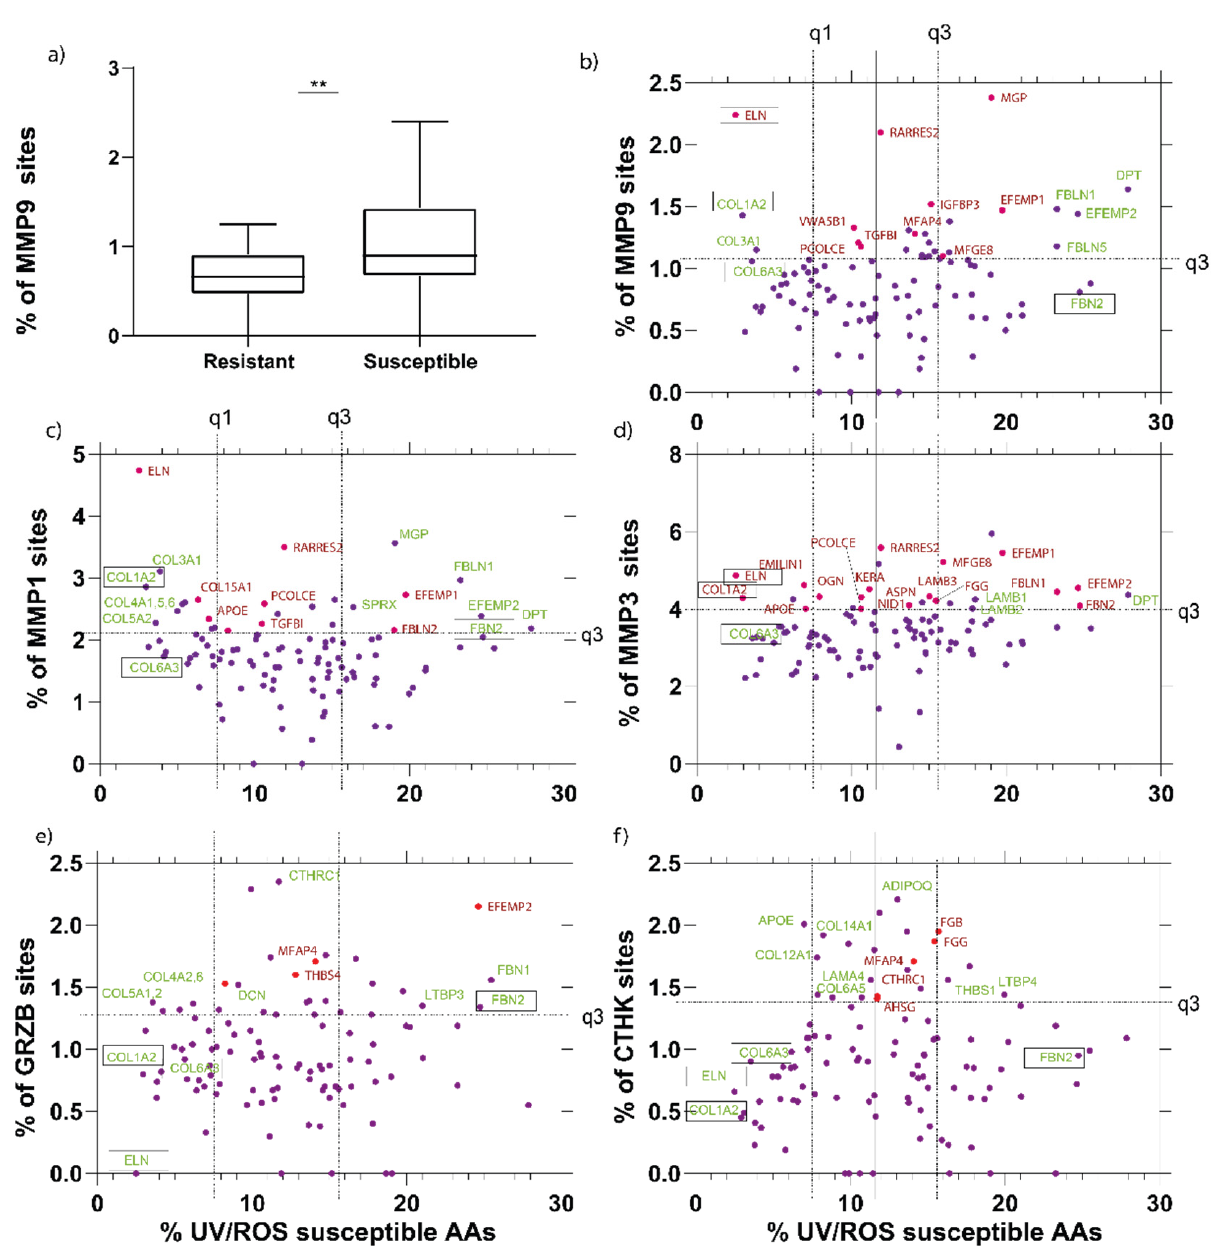
Figure 4. UVR/ROS vs. protease susceptibilities of MMP1, 3 and 7, granzyme B and cathepsin K of skin proteome-derived extracellular matrix (ECM) components. ( a ) Using the protein identities in the MMP9 degradation dataset, which had no MMP9 cleavage sites or had at least one cleavage site, allowed the evaluation of the MPC model’s performance to predict novel substrates. Proteins that had no experimental cleavage sites yielded significantly lower predicted MMP9 susceptibility scores. Having defined that susceptibilities could be analyzed using the MPC model, we used these models and analyzed the susceptibilities for MMP1 ( c ), 3 ( d ), and 9 ( b ), granzyme B ( e ), and cathepsin K ( f ). Proteins that were predicted as highly susceptible by PROSPER or DeepCleave only are labeled in red text. Proteins that are predicted as highly susceptible by MPC only are labeled in green text. Throughout, we have highlighted (boxed text) important skin proteins COL1A2, FBN2, ELN and COL6A3, which merit discussion.